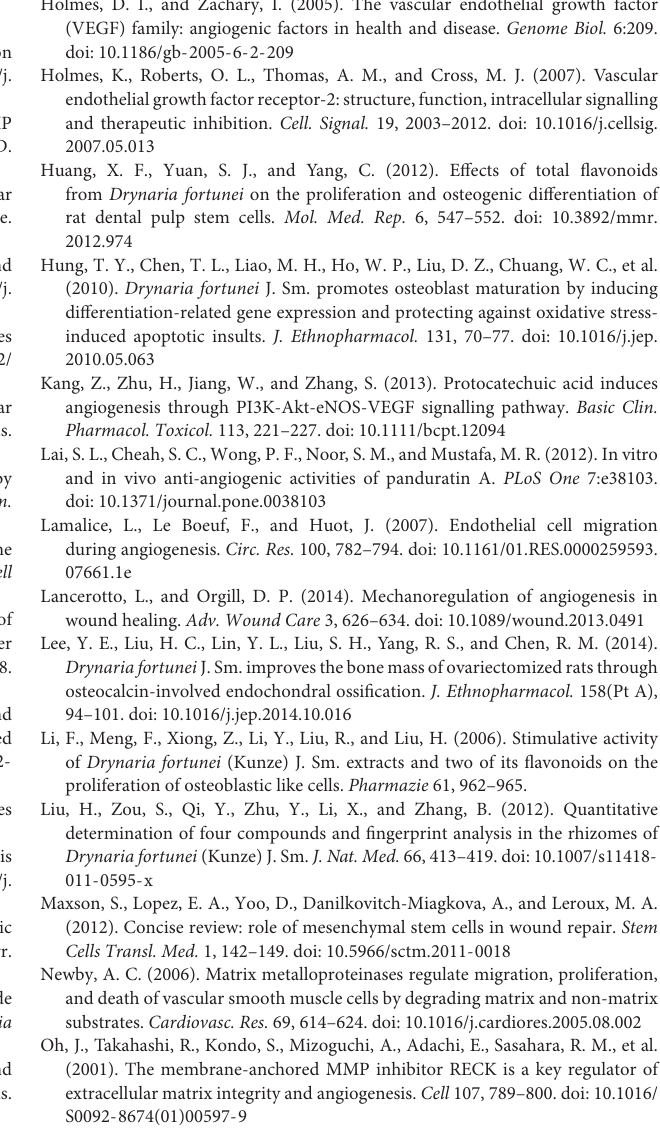
FIGURE S1 | D. fortunei without cytotoxic effect of HUVECs. (A) The cell viability was determined by standard MTT assay with different concentrations of D. fortunei as indicated for 24 h. (B) The cytotoxic effect of D. fortunei was evaluated by the LDH assay using the conditioned medium collected from HUVECs treated with different concentrations of D. fortunei as indicated for 24 h. (C) The cell viability was measured by MTT assay with different concentrations of PA as indicated for 24 h. No cytotoxicity of either D. fortunei or PA was detected under the experimental conditions. Data were mean ± SEM calculated from three individual experiments. FIGURE S2 | The original images of Western blots including MMP-2, MMP-14, TIMP-2, RECK, VEGF/VEGFRs, and actin. FIGURE S3 | The UV-Vis spectra for 3 - 1 , 3 - 2 , 3 - 3, and 3 - 4 . FIGURE S4 | The MS, MS/MS for 1 - 5 and base peak chromatography (BPC) for water extract of D. fortunei . TABLE S1 | Primer sequences.